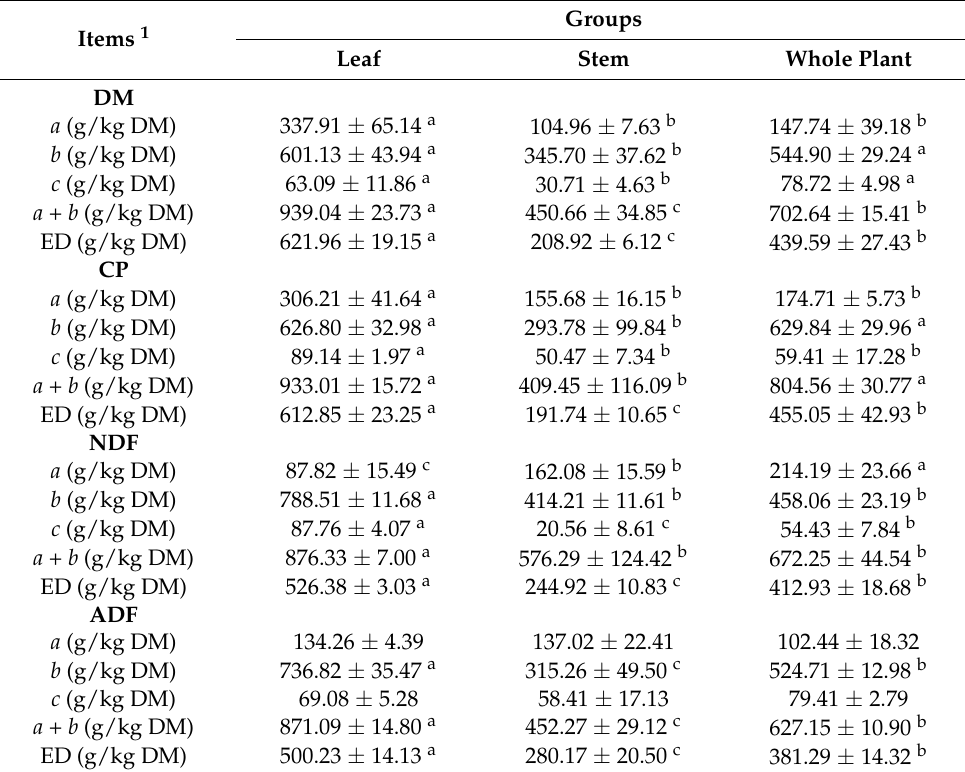
Table 5. Parameters of DM, CP, NDF, and ADF dynamic degradation model of different parts of paper mulberry